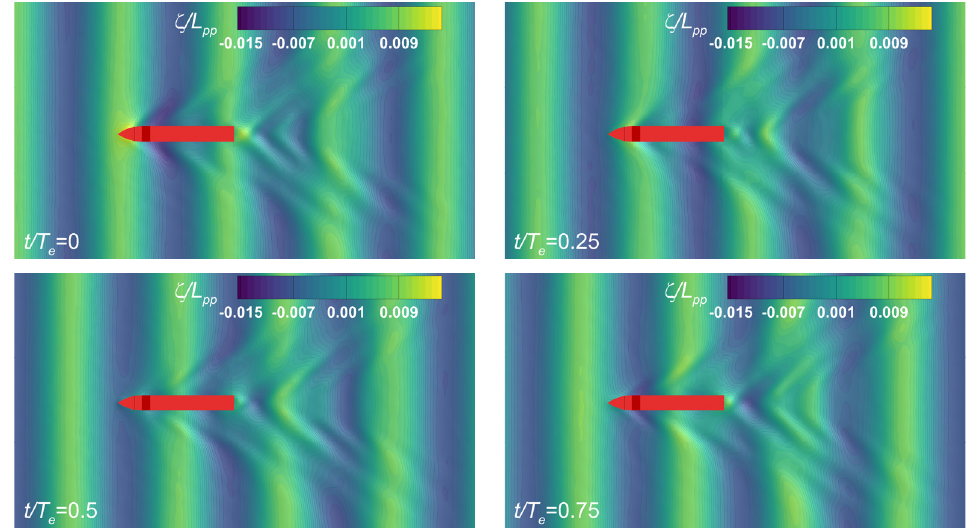
Figure 6. Free-surface elevations over a period of the head wave encounter.